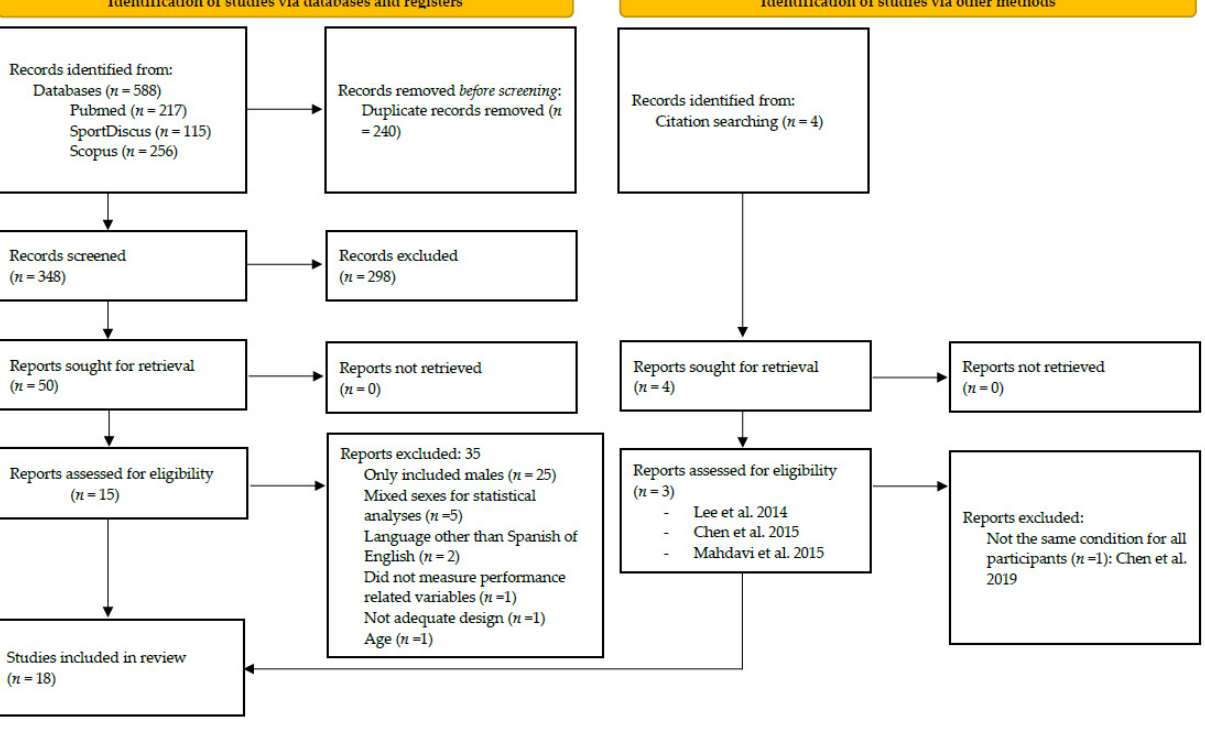
Figure 1. PRISMA flow-chart diagram.